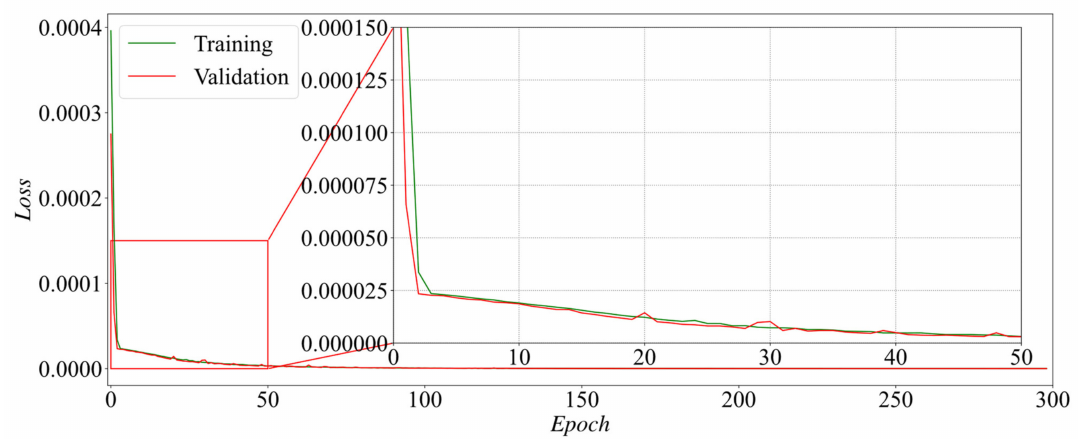
Figure 12. State prediction model loss trends for training and validation sets ( V comm